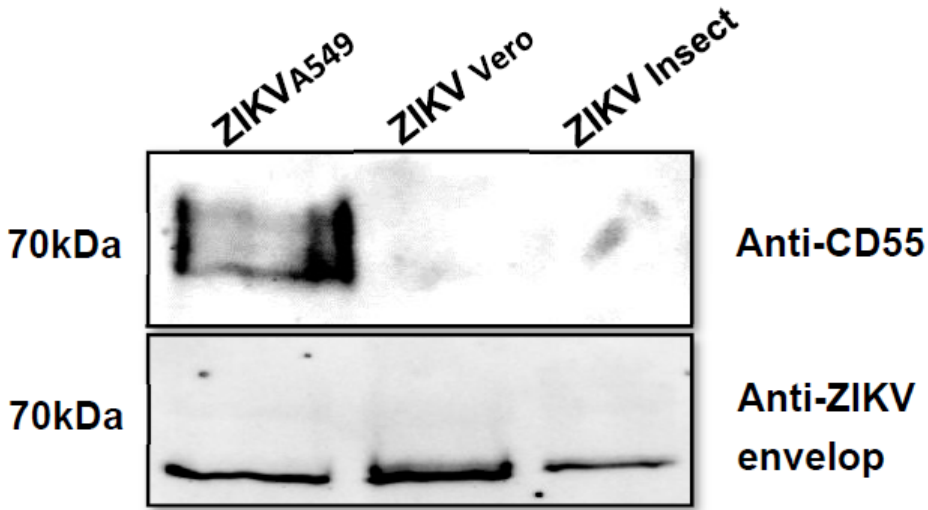
Figure 5. Western blot of ZIKV lysates confirms CD55 uptake. ZIKV-containing supernatants (concentrated) of infected A549, Vero, or Insect cells were characterized for CD55 incorporation by Western blotting. Samples were incubated with anti-human CD55 antibody. As load control, anti-ZIKV envelope was used. A representative Western blot analysis is